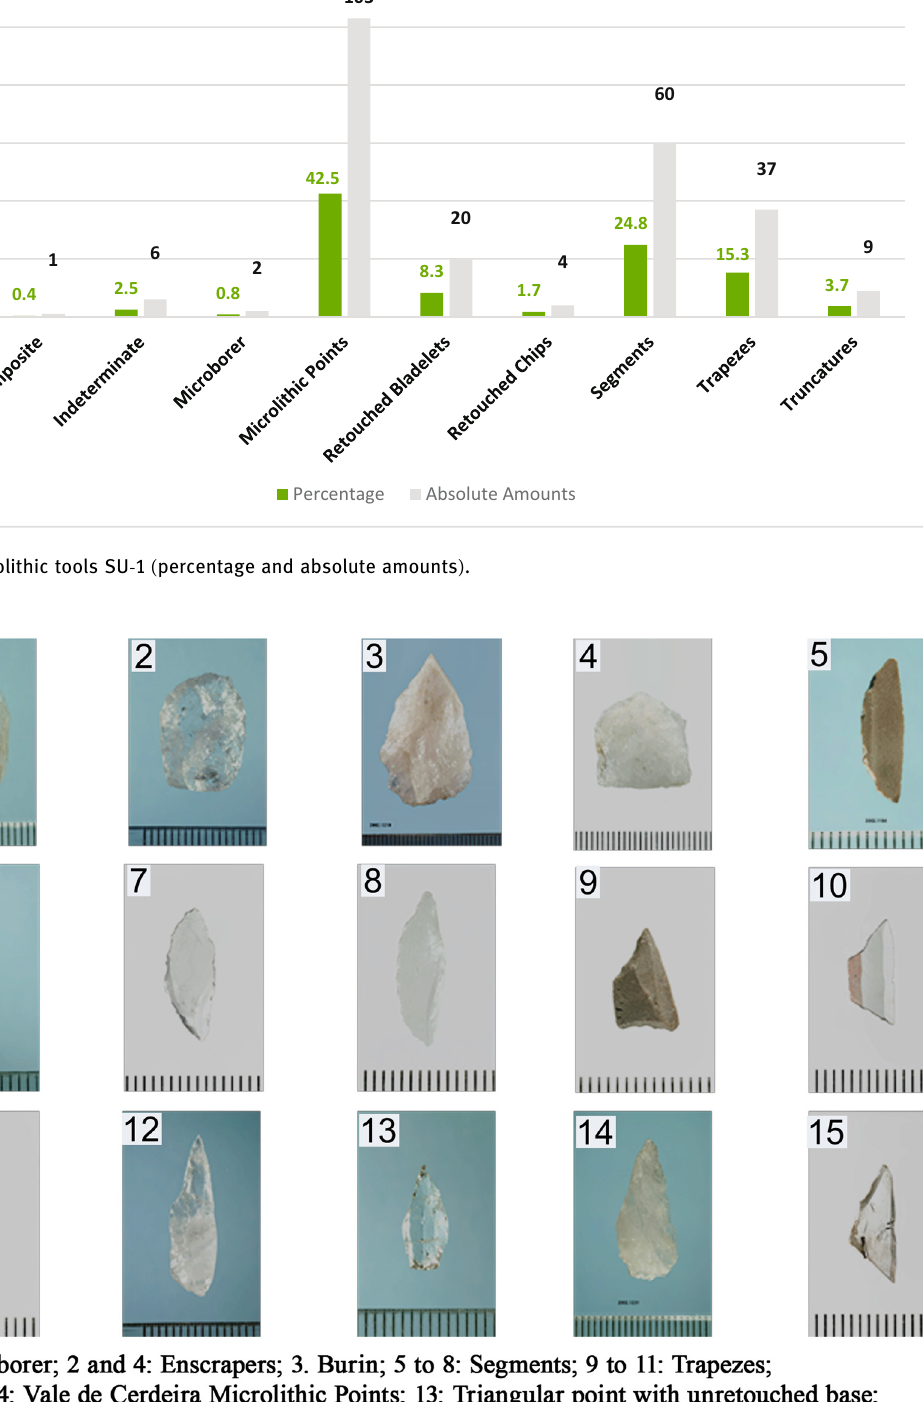
Figure 8: Tools from stratigraphic unit